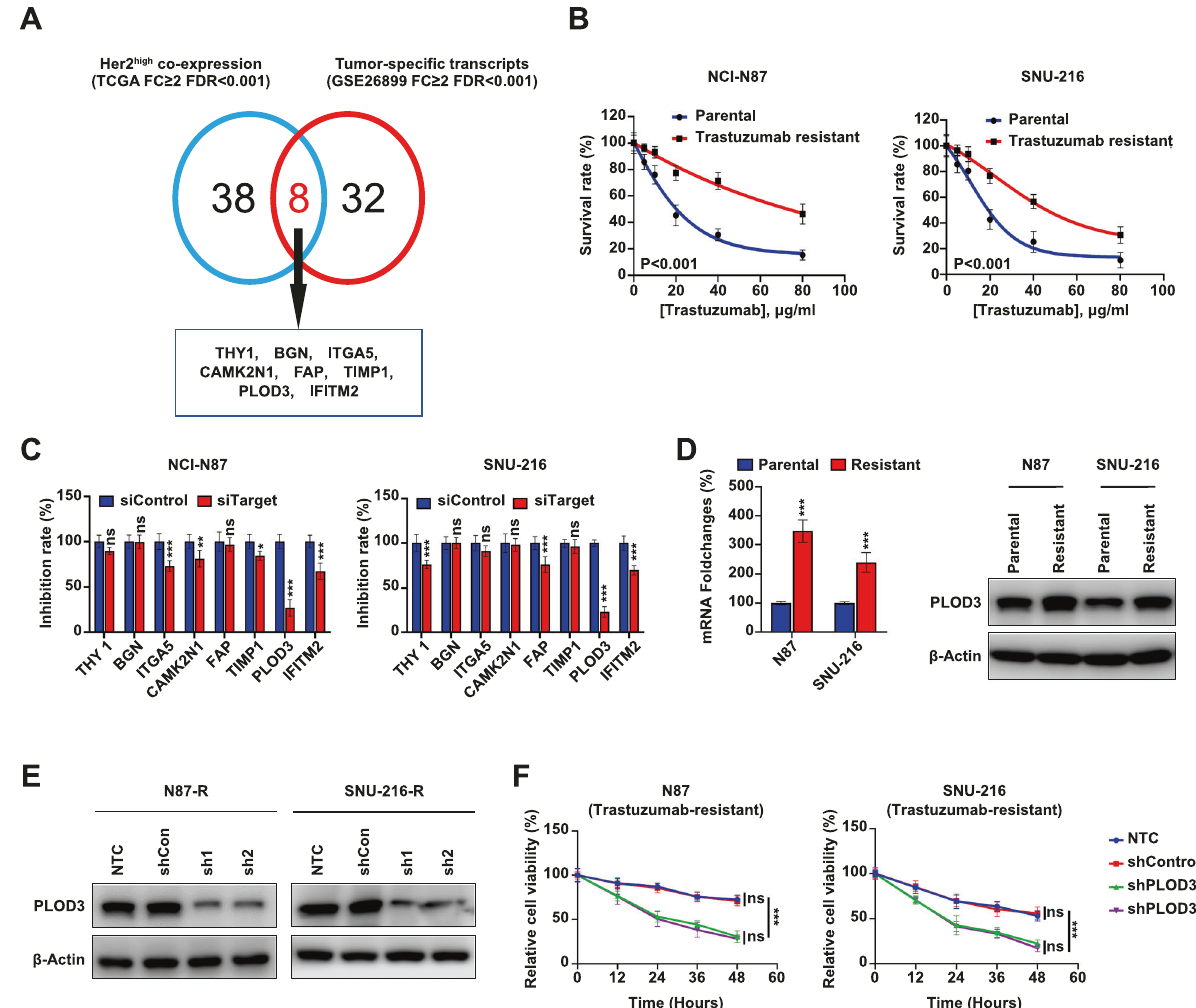
Fig. 1 Identi fi cation of PLOD3 as a novel regulator responsible for Trastuzumab resistance in gastric cancer. A Analysis of genes responsible for Trastuzumab resistance in gastric cancer from TCGA database and RNA-Seq database(GSE26899). B The trastuzumab-resistant GC cell lines were generated by treating HER-2 positive parent cell lines N87 and SNU-216 with trastuzumab, and the resistance potentials were veri fi ed by MTT assays. C The siRNA depletion of indicated targets were conducted in NCI-N87 and SNU-216 cells followed by MTT assays to determine the inhibition ef fi ciency. Silencing PLOD3 signi fi cantly decreased cell proliferation when compared to other genes when treated with Trastuzumab. D Expression of PLOD3 in Tr cells and parental cells were determined by quantitative PCR and western blot. E Established Tr cell lines with PLOD3 depletion by two independent shRNAs (sh1, sh2) and validated by western blot. F The proliferation in both N87 and SUN-216 Tr cells were con fi rmed by